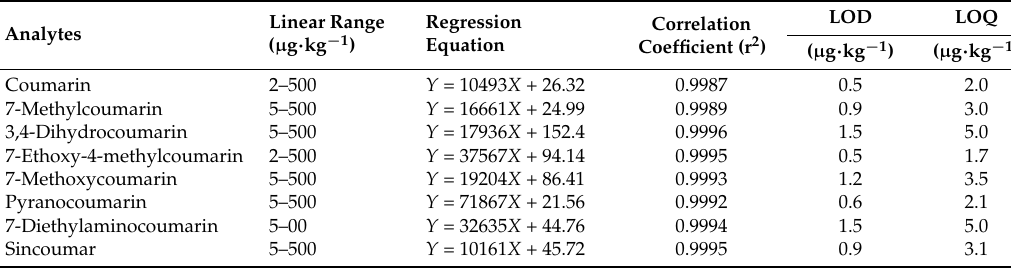
Table 2. Linear range, correlation coefficient, limits of detection (LOD) and limits of quantification (LOQ) for coumarin and its